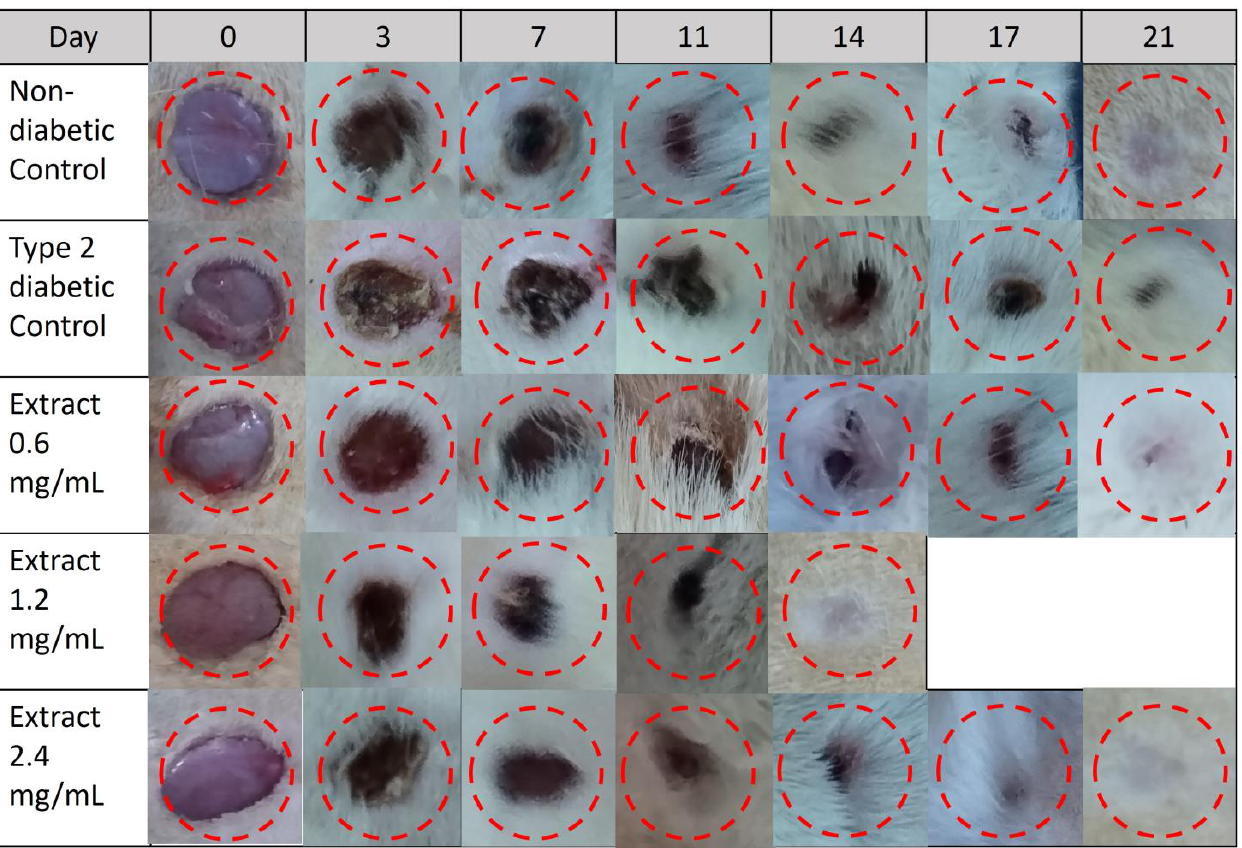
Figure 7. Representative photographs of the effect of E. hyemale extract (0.6, 1.2, and 2.4 mg/mL) on wound closure during 21 days in type 2 diabetic rats. Non-diabetic control and type 2 diabetic control groups were treated with physiological saline (0.9%).